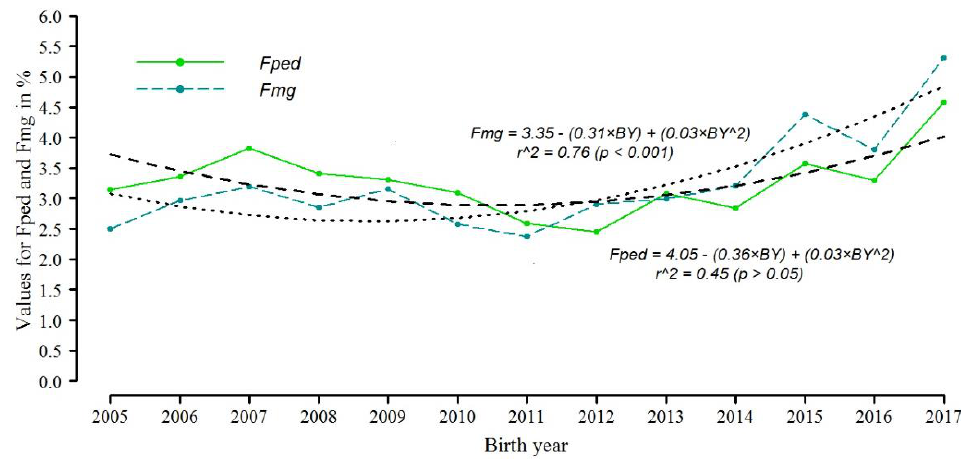
Figure 1. Distribution of inbreeding coefficients calculated through pedigree (Fped) and calculated through genomic relationship matrix (Fmg), from 2005 to 2017, with trends lines. BY: Birth year recoded from 1 to 13, BY^2: Squared recoded birth year.